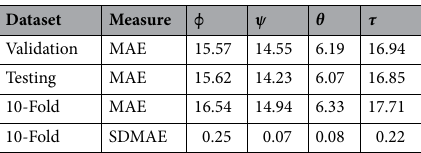
Table 4. Average performance of the best settings of SAP after 10-fold cross validation is performed.